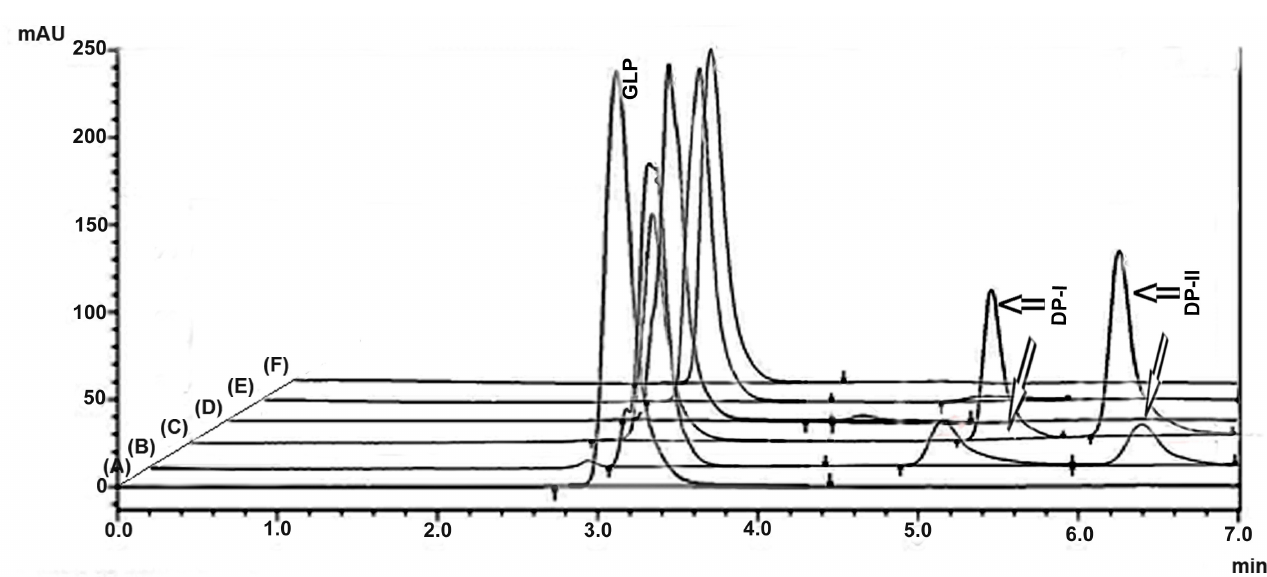
Table IV - Results of forced degradation study